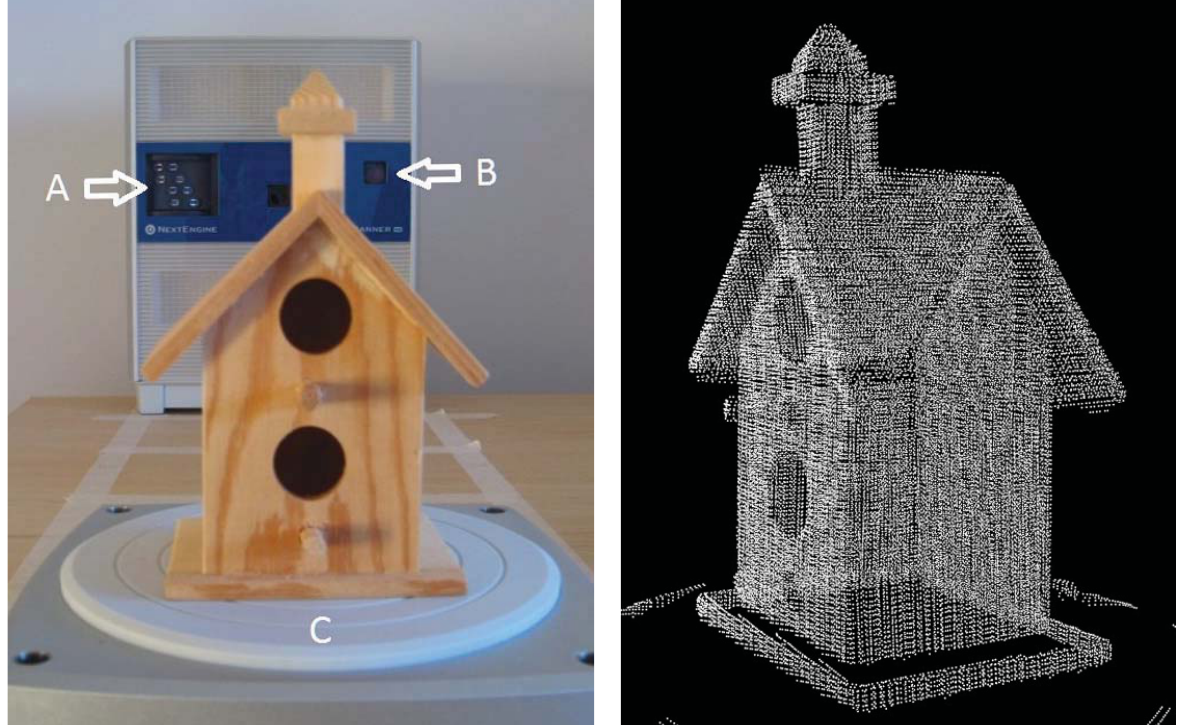
Figure 1. Left: A wooden birdhouse was scanned 20 times both in Macro and Wide Mode (40 scans in total) using a motorised turntable (A: laser; B: camera; C: turntable). Right: A view of the 3D point cloud generated by the